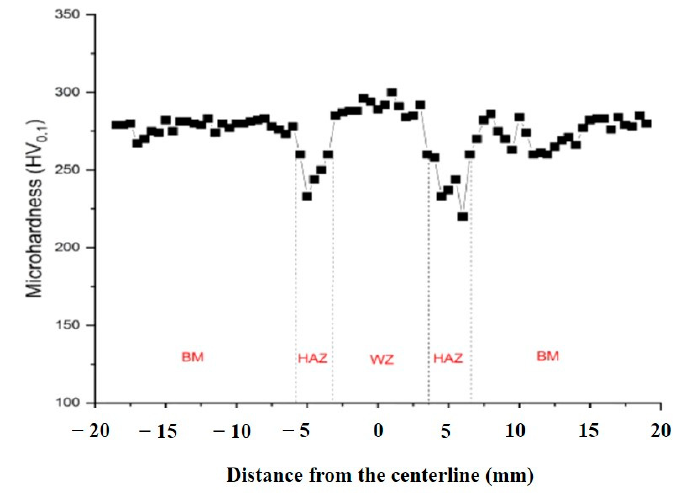
Figure 13. Microhardness profile of GTAW’ed XPF800. Reprinted with permission from ref. [37]. Copyright 2021, Elsevier. Copyright 2021,